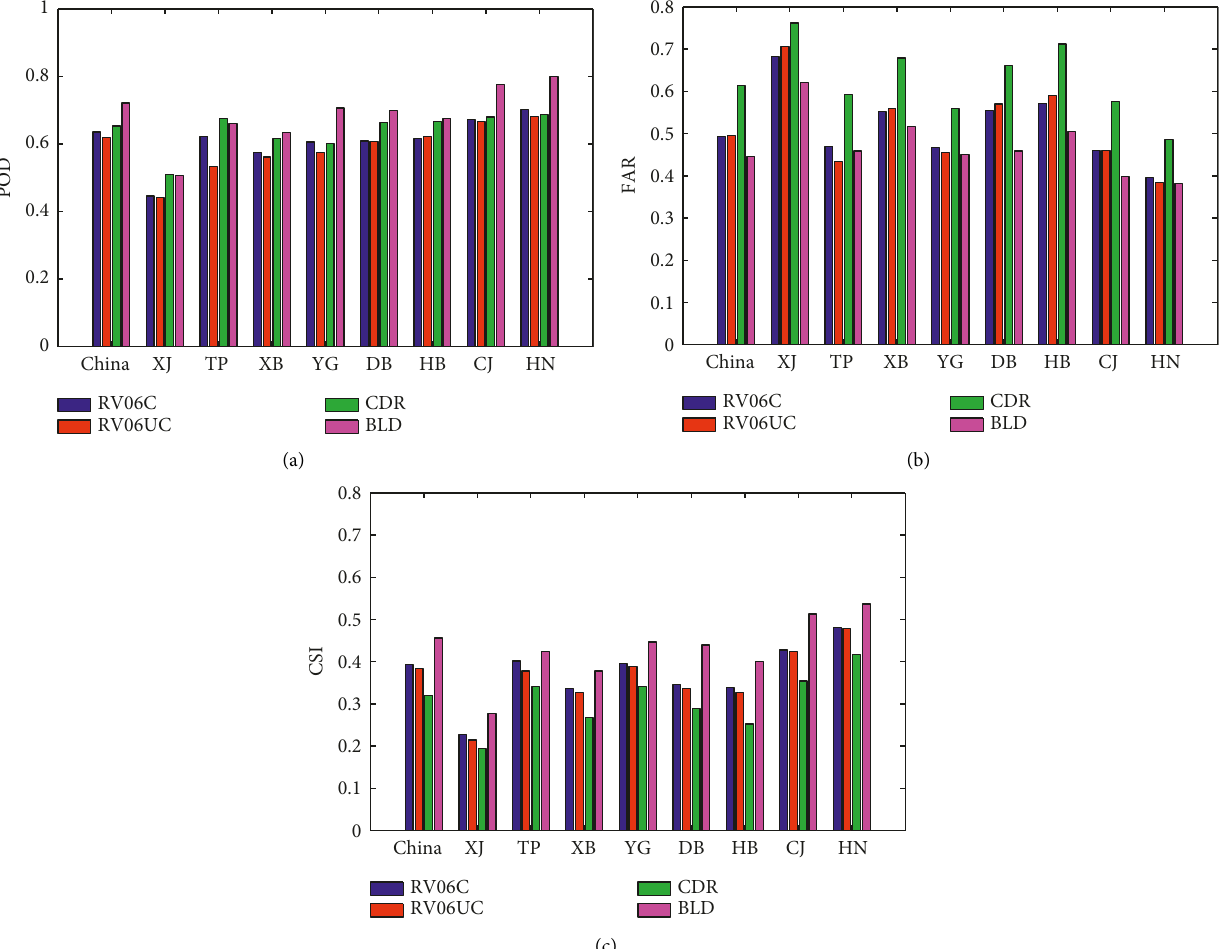
Figure 8: Categorical statistical indices: (a) POD, (b) FAR, and (c) CSI of daily precipitation for RV06C, RV06UC, CDR, and BLD satellite- based products compared to precipitation gauges over Mainland China and its eight subregions from March 2014 and June